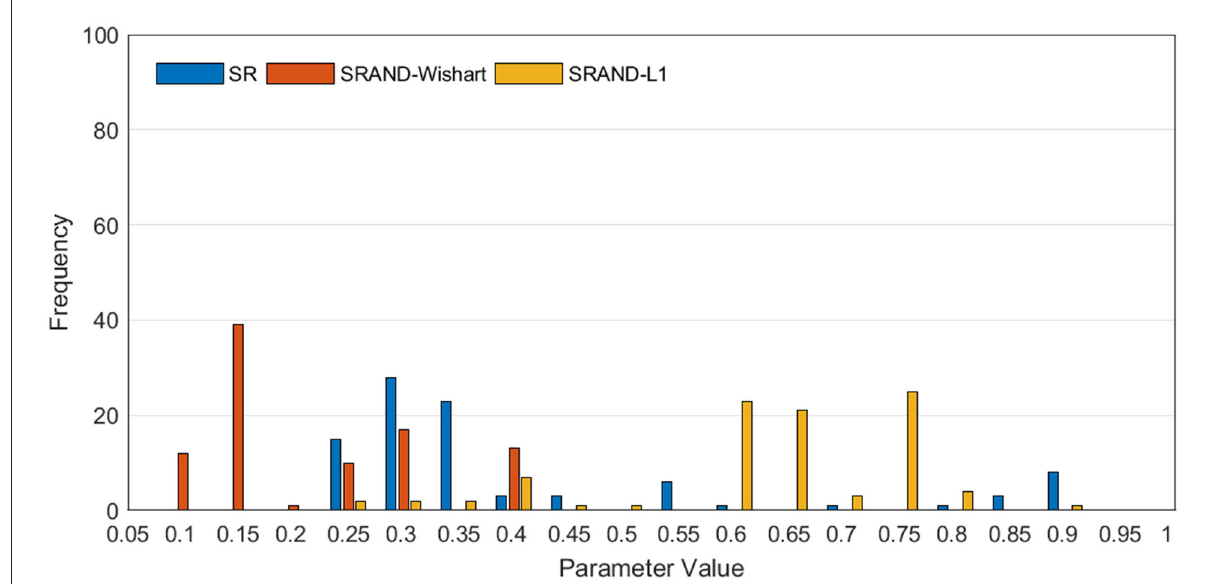
FIGURE4 Frequency of the selected optimal values of parameter λ in the inner loops, where the horizontal axis represents the candidate parameter values, and the vertical axis represents the frequency of the parameter value being selected via parameter selection.